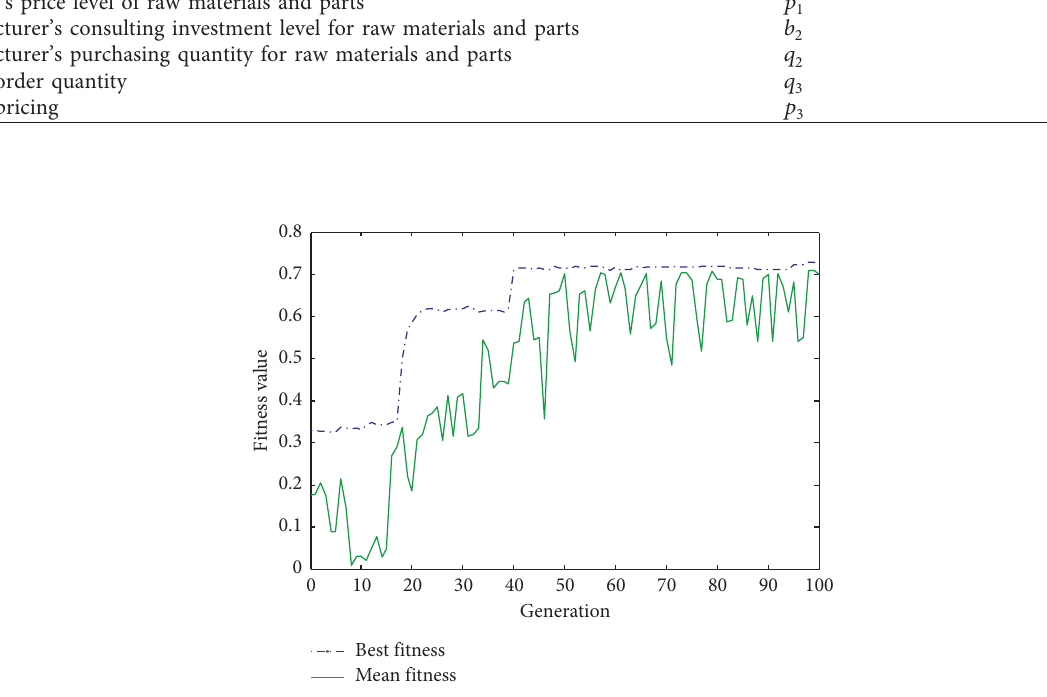
Figure 3: Trajectory of evolutionary process over 100 iterations.